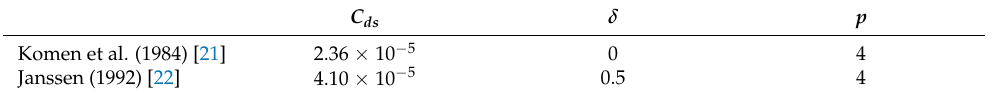
Table 2. White capping coefficients as determined by Komen et al. (1984) and Janssen (1992). C ds Komen et al. (1984)